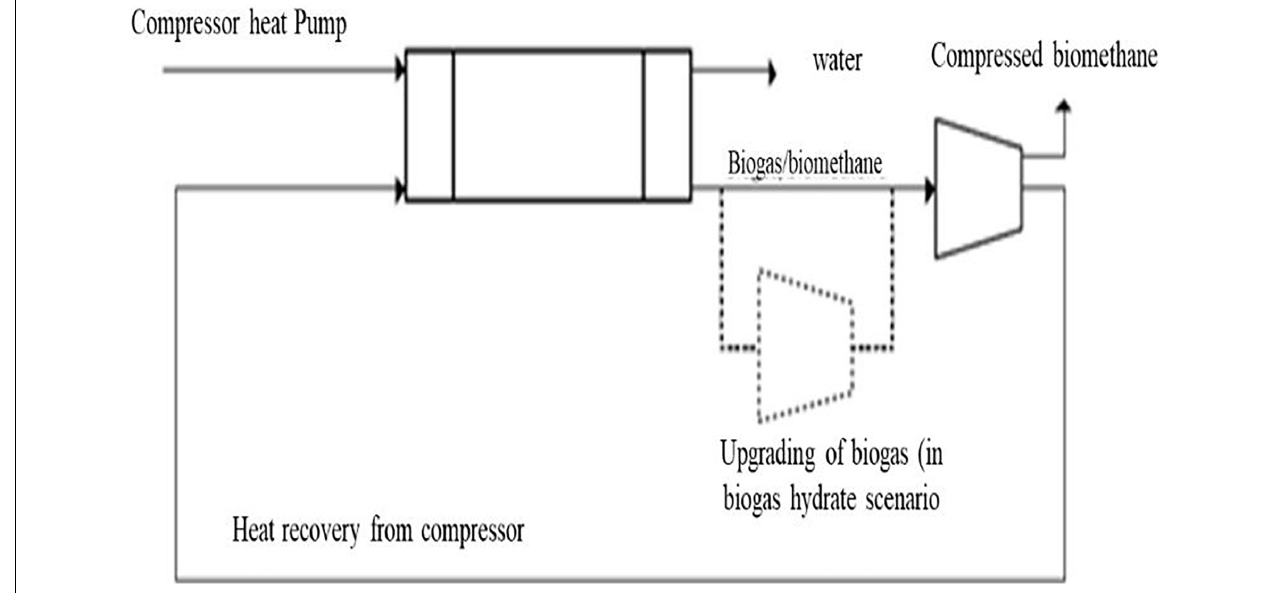
FIGURE 3 | Flow scheme of the dissociation process involving a compressor heat pump and recovery of heat from compression of biornethane.